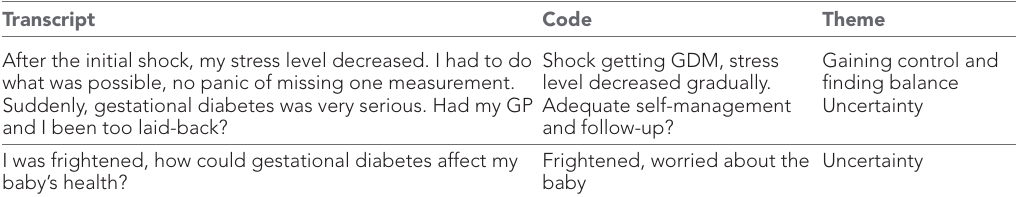
Table 1 Example from the data analysis of transforming transcripts to codes and themes Transcript Code